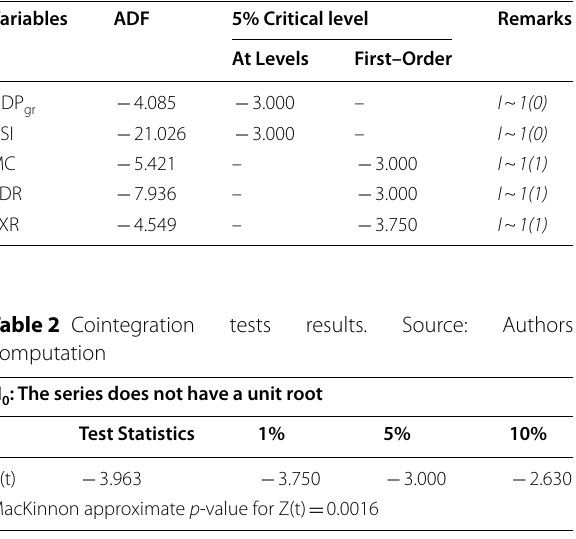
Table 1 Tests for stationarity. Source: Authors computation with data generated from NSE and NBS